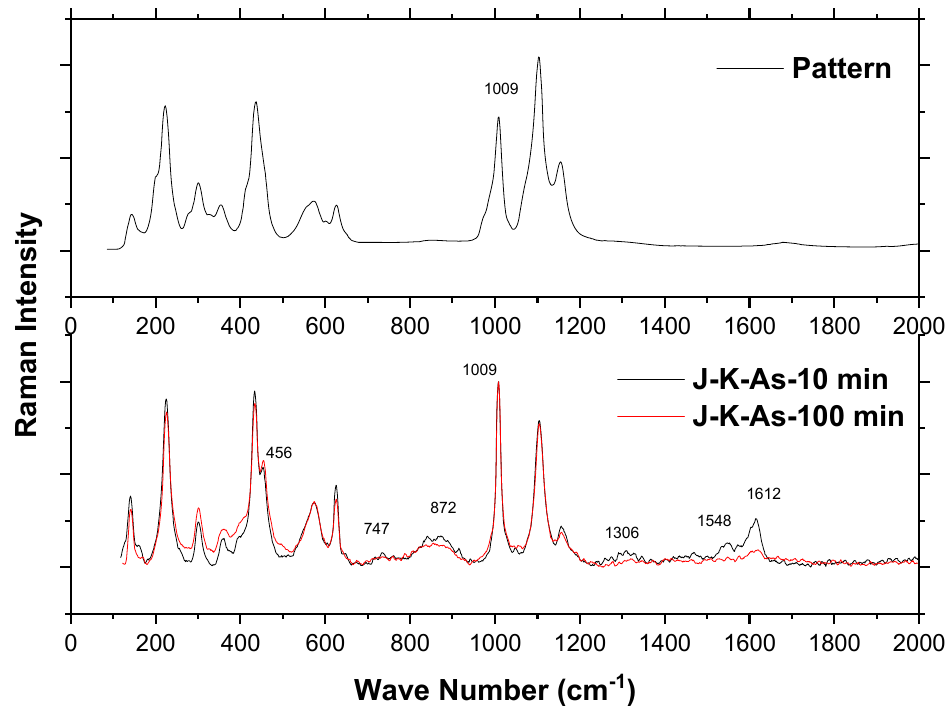
Figure 8. Raman spectra of the potassium jarosite with As(V) compared to potassium jarosite without As(V).